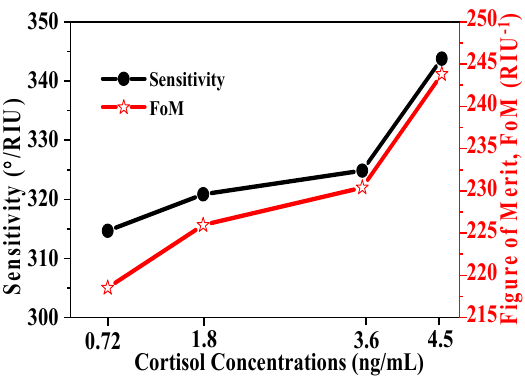
Figure 4. SPR angle, R min , and FWHM for different cortisol concentrations (0.36 to 4.5 ng/mL).